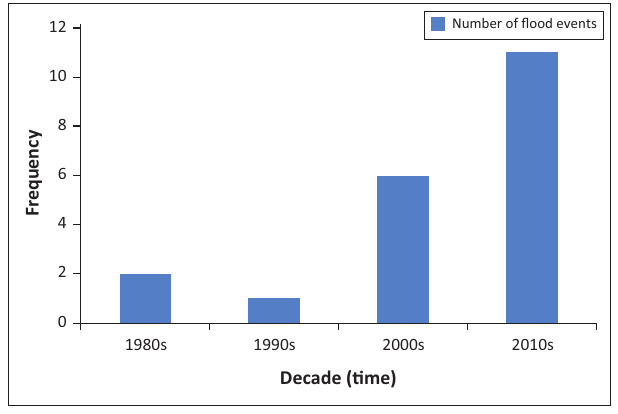
FIGURE 3: Flood events and trends between the 1980s–2010s (flood